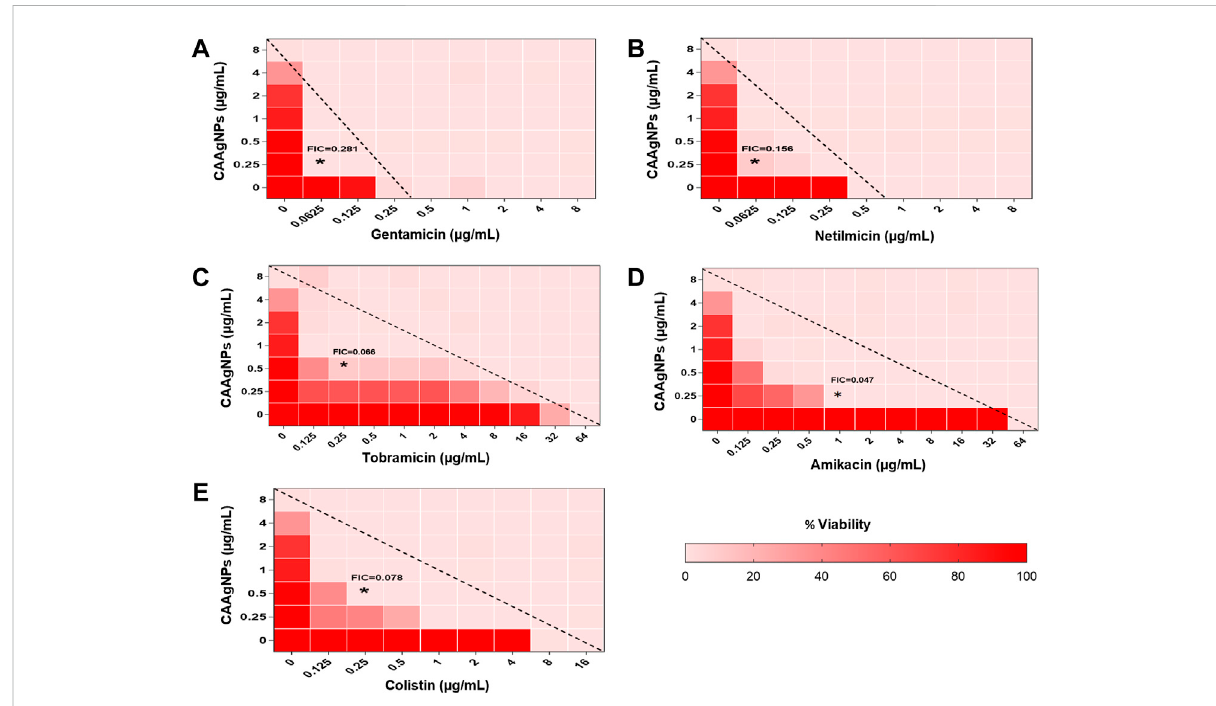
FIGURE 9 Heat plots demonstrating synergistic effect of CAAgNPs in combination with antibiotics against P. aeruginosa PAW1. Representation of normalized values of percent viability after treatment of CAAgNPs (0 – 8 μ g/ml) with (A) Gentamicin (0 – 8 μ g/ml), (B) Netilmicin (0 – 8 μ g/ml), (C) Tobramycin (0 – 64 μ g/ml), (D) Amikacin (0 – 64 μ g/ml), and (E) Colistin (0 – 16 μ g/ml) respectively. Untreated cells with hundred percent viability indicated by darker red boxes. Lighter red boxes indicate reduced cell viability. Dashed line passes through the MICs and “ * ” (asterisk) below it represents the FICi values suggesting a synergistic